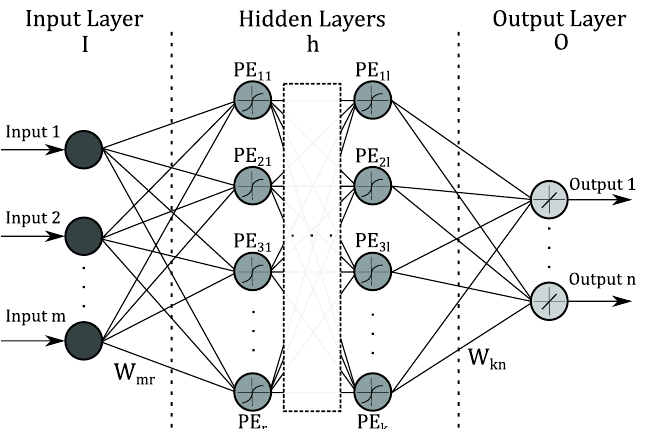
Figure 7. Neural network: example of a feedforward structure, with m input nodes, several hidden layers with specific numbers of processing units (PE) each implementing a nonlinear function (i.e., sigmoid), n output nodes implementing a linear function and interconnections weights (i.e., W kn and W mr ).